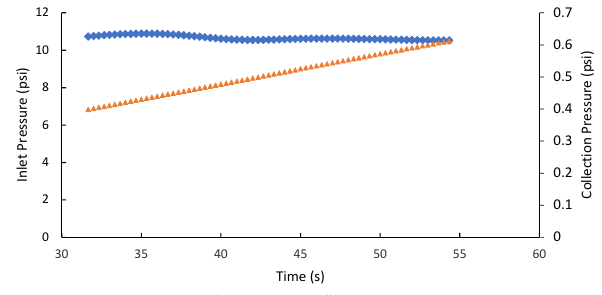
Fig. 1 Permeability of different sand grades